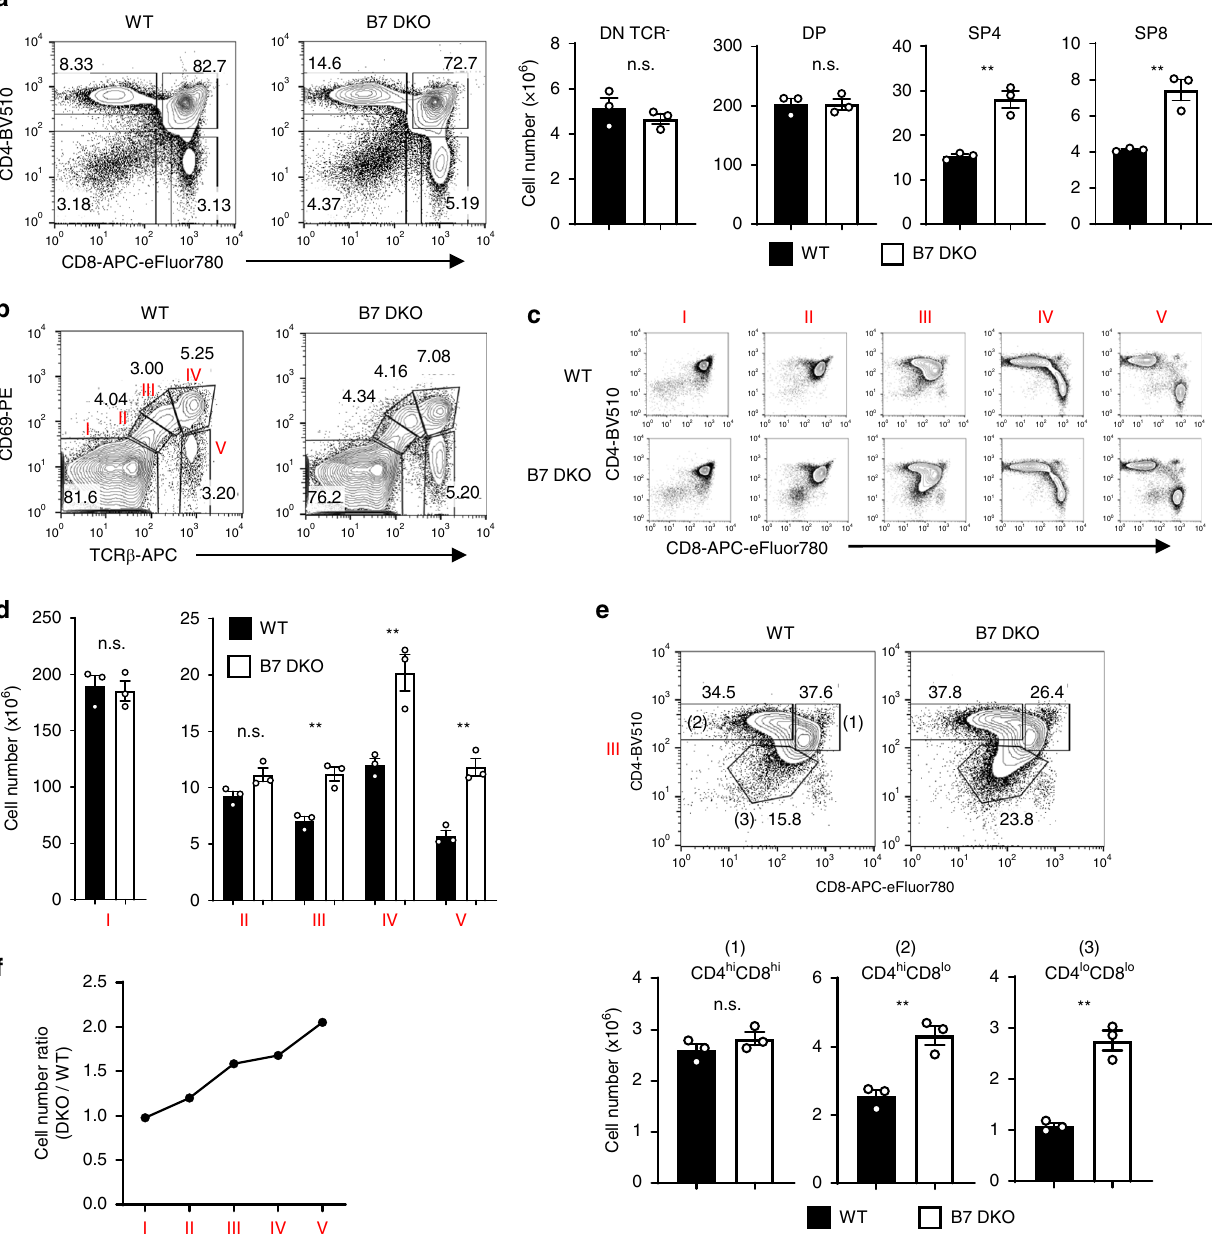
Fig. 1 In the absence of B7-CD28 co-stimulation, thymocyte numbers increase progressively after positive selection. a The number of single-positive thymocytes was increased in B7 DKO mice. SP4 p = 0.0026, SP8 p = 0.0047. b Thymocyte developmental stages de fi ned by TCR vs. CD69 expression. c CD4 and CD8 pro fi le in each thymocyte developmental stage. d Thymocyte number in each developmental stage. Stage III p = 0.005, Stage IV p = 0.0089, Stage V p = 0.0026. e Thymocyte cell number in subpopulations of stage III. CD4 hi CD8 lo p = 0.006, CD4 lo CD8 lo p = 0.0012. f Relative thymocyte number in B7 DKO compared to WT mice increased progressively after stage III. Each group n = 3. Data are representative of three independent experiments. a , d , e Data are mean ± SEM with dots representing individual values of biologically independent animals. Statistical differences between groups were calculated using unpaired, two-tailed Student ’ s t -test. ** p < 0.01. n.s.; not signi fi cant. Source data are provided as a Source Data fi